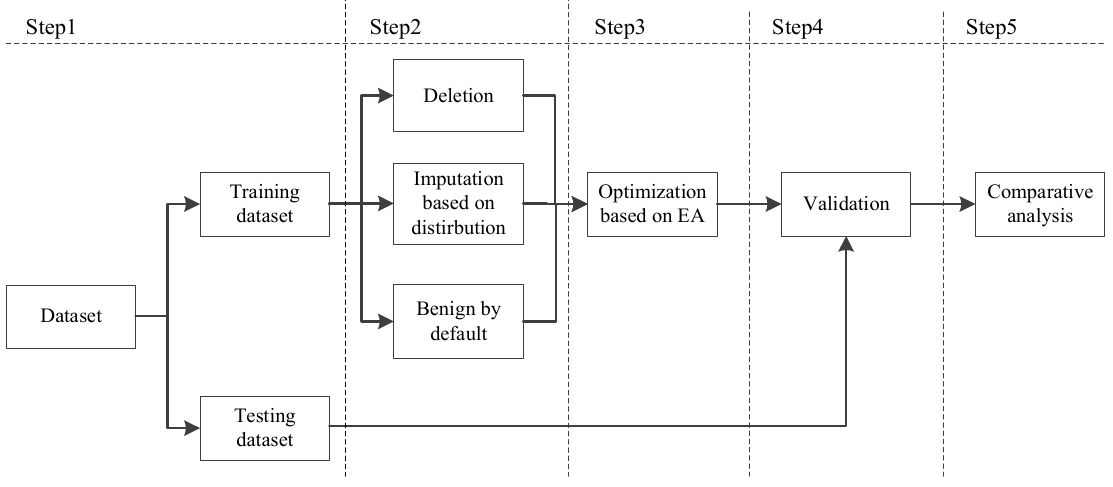
Figure 2. Thyroid nodule diagnosis approach using BRB under different assumptions.